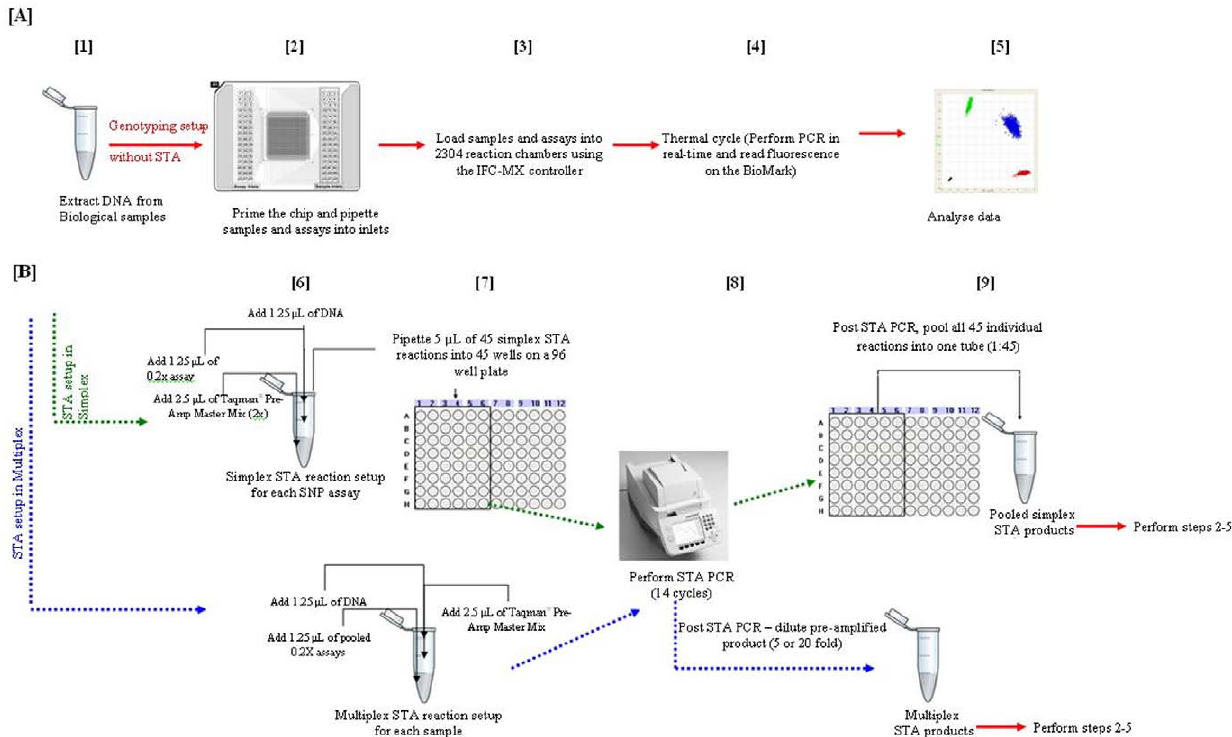
Figure 5. Genotyping analysis workflow with and without STA. [A] Steps 1–5 (denoted in red arrows) correspond to TaqMan H SNP-GT protocol without STA or following simplex or multiplex STA. [B] Steps 1, 6–9 corresponds to STA reaction setup in simplex and multiplex conditions. Post STA, the amplified products are pooled (simplex STA), or further diluted 5 or 20 fold (multiplex STA) prior to performing TaqMan H SNP-GT setup using steps